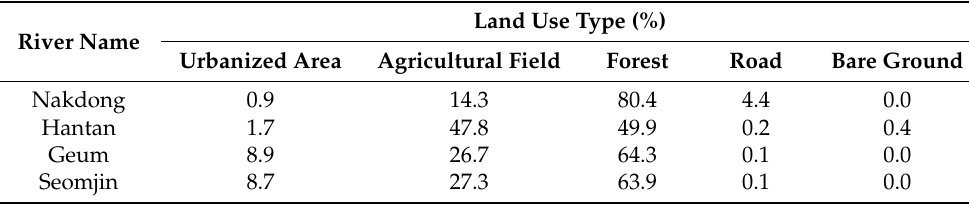
Table 1. The land use pattern in the watershed surrounding the midstream reach of the Hantan River, the upstream reach of the Geum River, the midstream reach of the Seomjin River, and the upstream reach of the Nakdong